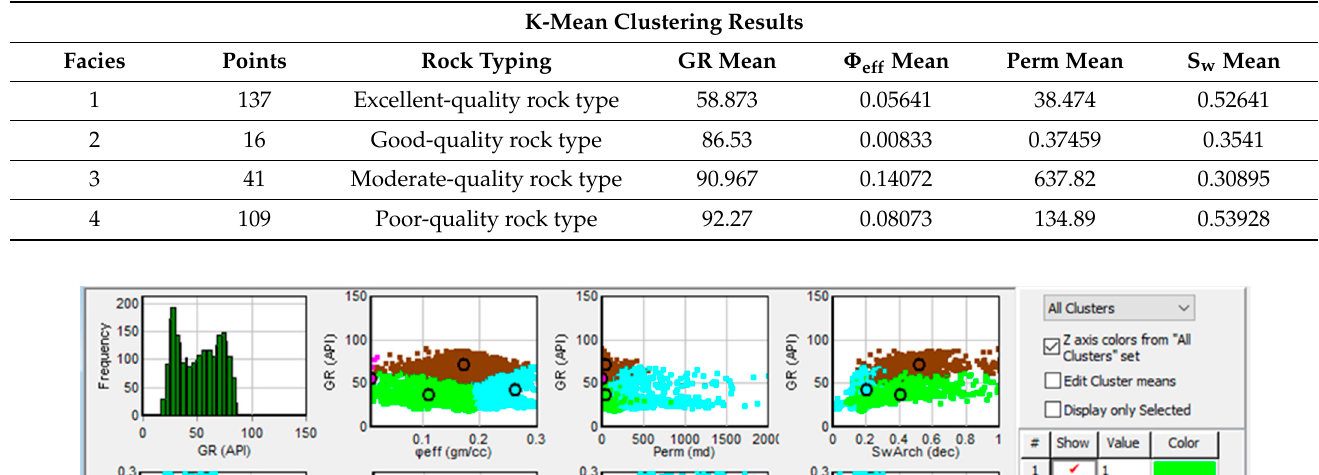
Table 4. Outcomes of the cluster analysis for every type of rock.